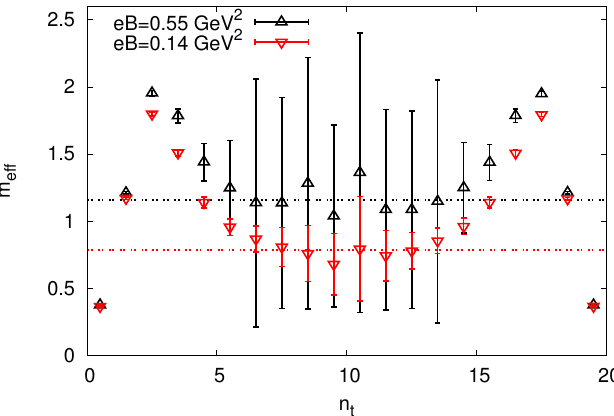
Figure 3. The e(cid:11)ective mass of the (cid:26) + ( (cid:26) (cid:0) ) meson with the s z = (cid:0) 1 ( s z = +1) spin projection for m (cid:25) ( B = 0) = 535(4) MeV. The lines correspond to the (cid:12)ts of the m e(cid:11) by the constant function at n 0 =